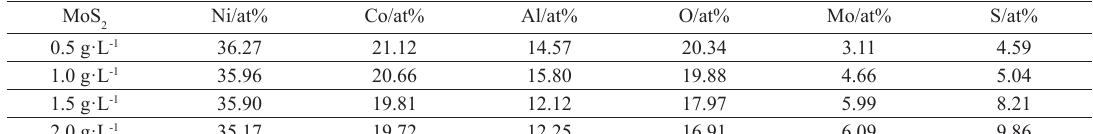
Table 2. Results of energy spectrum analysis of the coatings. MoS